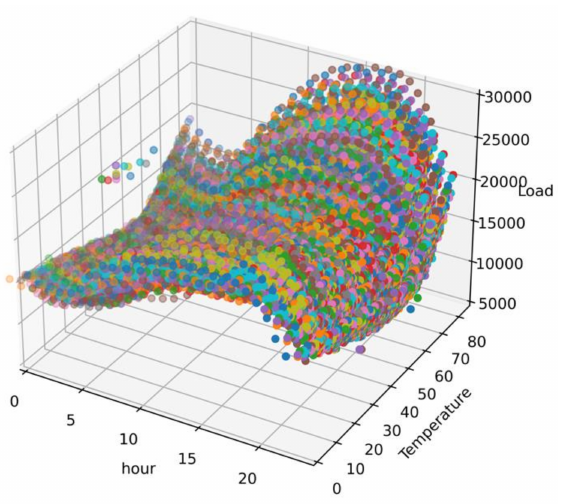
Figure 3. Nonlinear correlation with respect to load, temperature, and